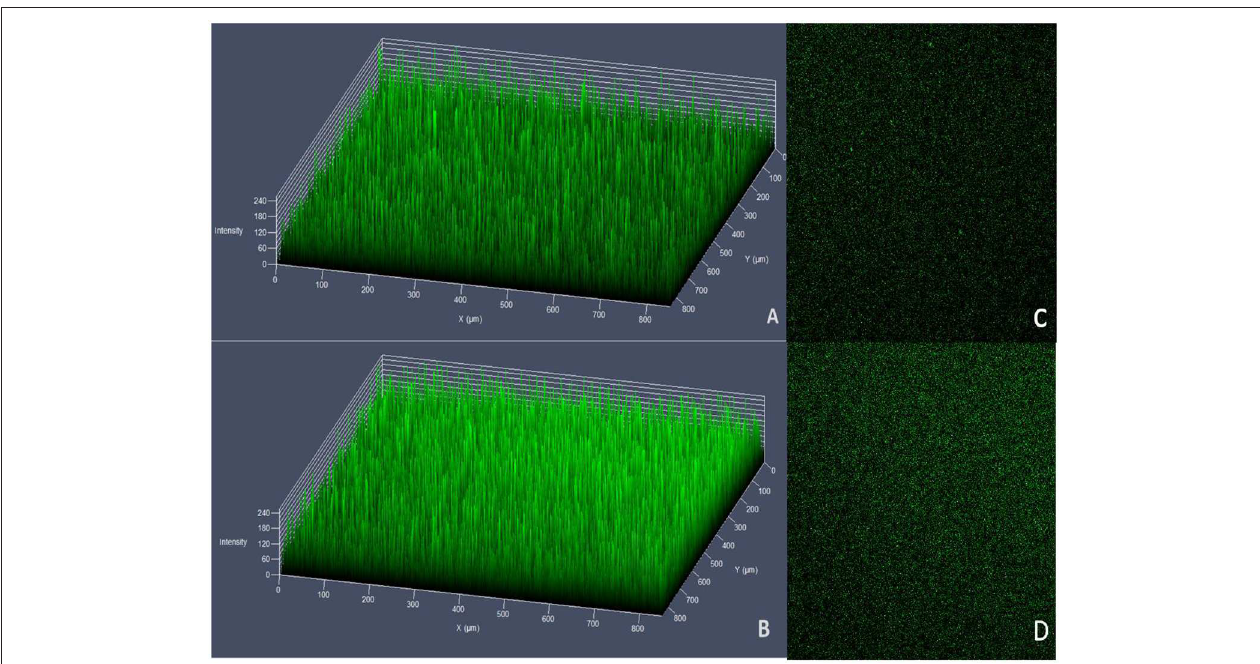
FIGURE 7 | Measurement of biofilm by LSCM. (A) HY9901 2.5d diagram. (B) HY9901 1 tyeA 2.5d diagram. (C) HY9901 2d diagram. (D) HY9901 1 tyeA 2d diagram; HY9901 Biofilm thickness:60 ± 10 µ m, HY9901 1 tyeA Biofilm thickness:90 ± 20 µ